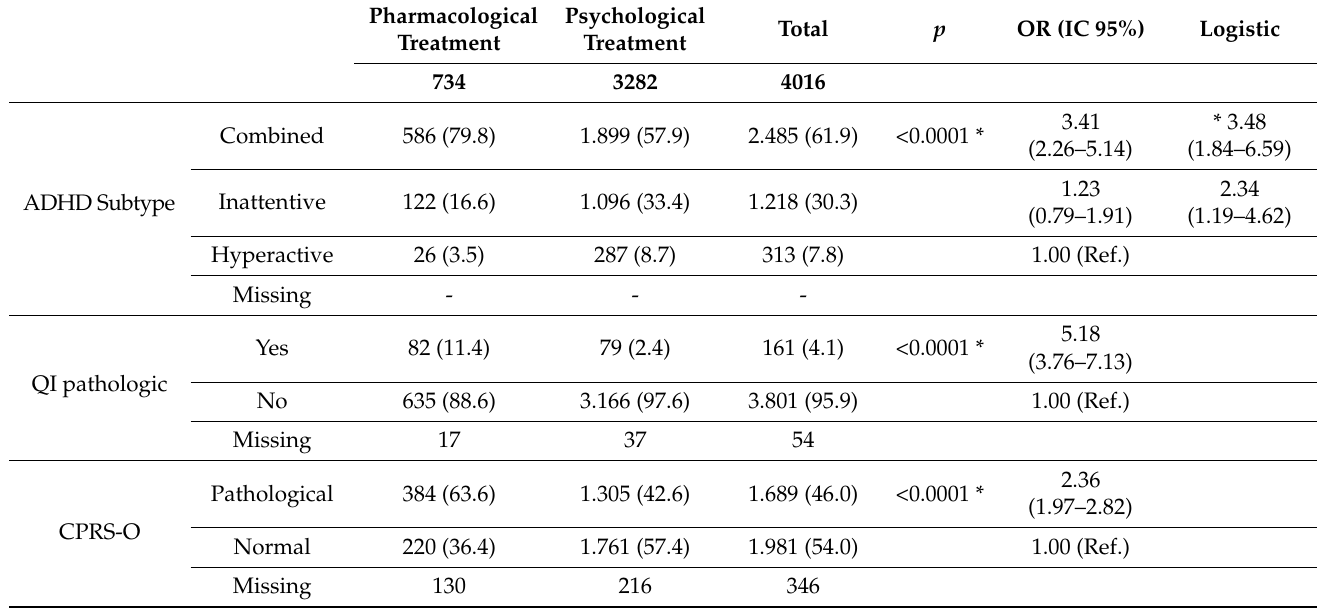
Table 2. Clinical characteristics of the ADHD patients by treatment